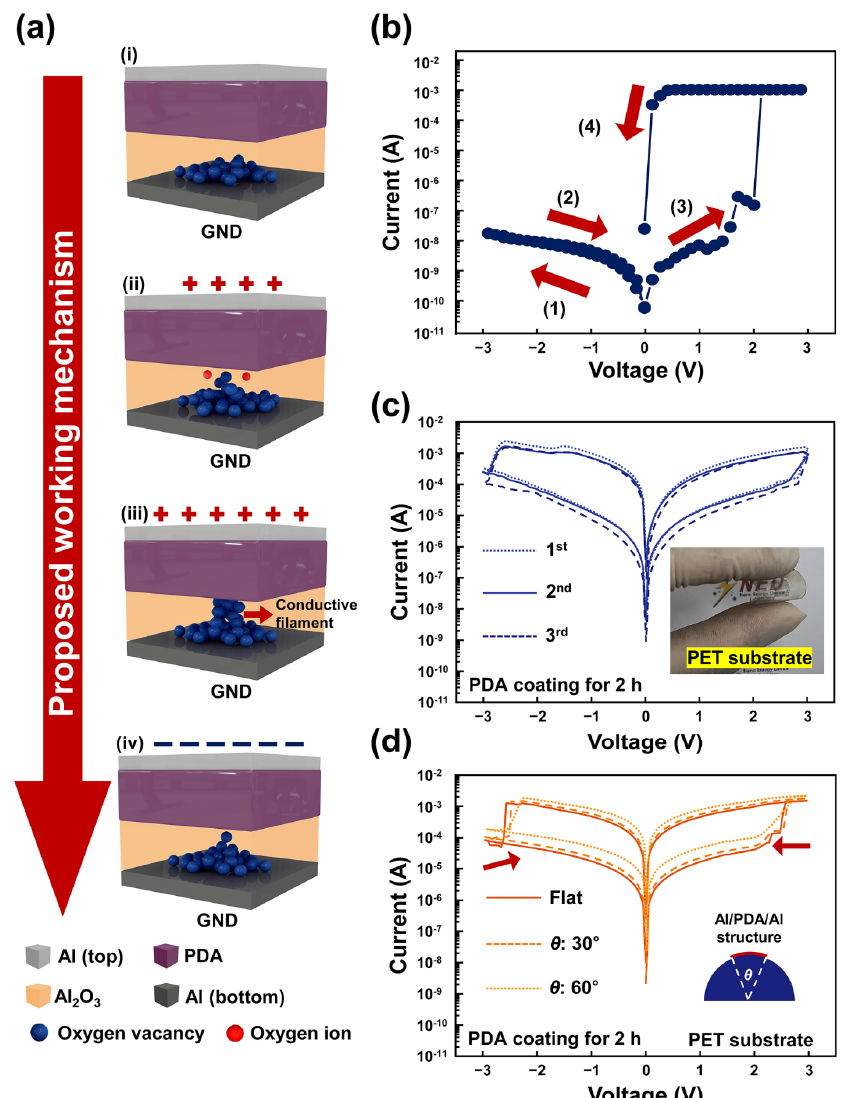
Figure 4e,f. When the sufficient forward-bias voltage is applied to the top Al electrode, the PDA insulator layer breaks down, and oxygen ions in the naturally formed Al 2 O 3 layer between the bottom Al electrode and the PDA layer migrate toward the PDA layer, as shown in Figure 5a(ii). Due to the electric field, the oxygen ions can be escaped from the oxygen lattice. After the migration of the oxygen ions, conductive filaments form due to the oxygen vacancies, as shown in Figure 5a(iii). Electrons can, therefore, flow due to the conductive filaments formed between the PDA layer and the bottom Al electrode. Then, resistive switching occurs and the Al/PDA/Al structure is in the LRS state. When the reverse-bias voltage is applied to the Al/PDA/Al structure, the formed conductive filaments are ruptured as shown in Figure 5a(iv). As a result, resistive switching occurs from the LRS state to the HRS state.